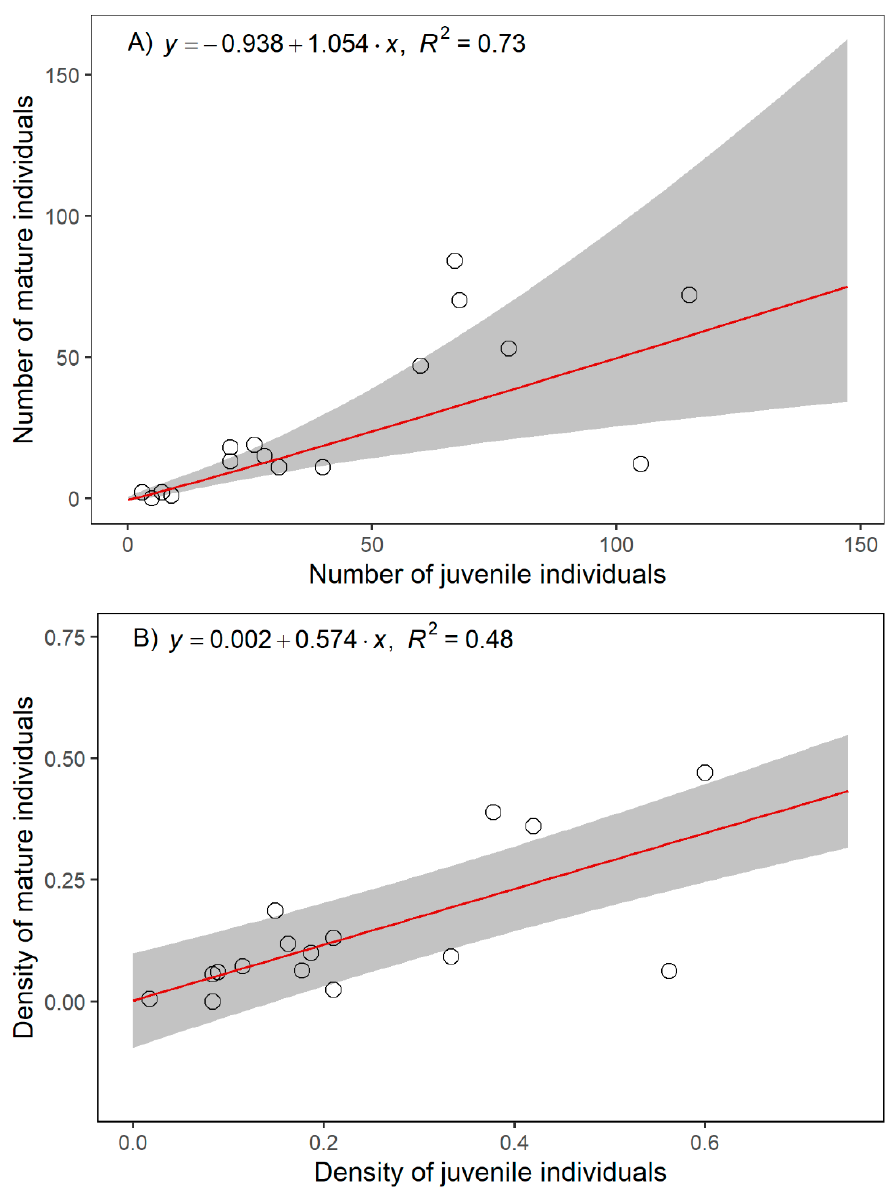
Figure 2. Relationship among mature and juvenile individuals of Cirsium alpis-lunae . ( A ) Relationship among a number of juvenile and mature individuals. Regression line parametrised in log–log spaces and back-transformed to linear scale to plot the actual numbers of the populations. ( B ) Relationship among the density of juvenile and mature individuals. Circles represent actual number and density values (in A and B, respectively) of Cirsium alpis-lunae mature and juvenile individuals. Matures and juveniles were affected by roughly the same variables (Table 2, see ta-